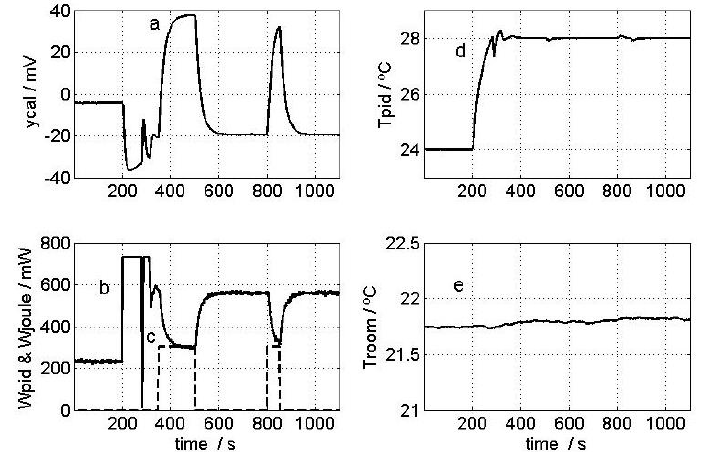
Figure 6. Input and output curves used in the calibration: ( a ) Calorimetric signal; ( b ) Power dissipated in the thermostat resistor; ( c ) Power dissipated into the calibration base by the Joule effect; ( d ) Thermostat temperature; and ( e ) Room temperature.